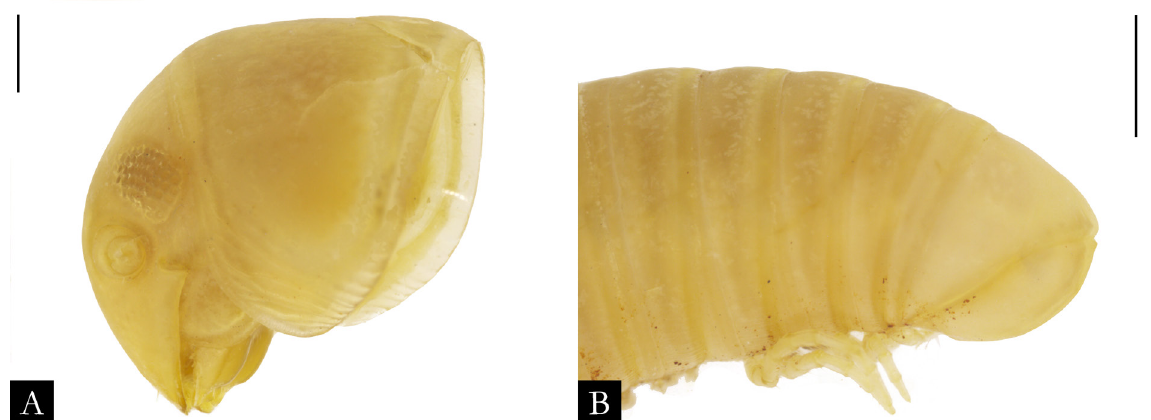
Fig. 106. Pseudonannolene patagonica Brölemann, 1902, holotype, ♂ (MZSP 0242), in lateral view. A . Anterior region. B . Posterior region. Scale bars = 0.5